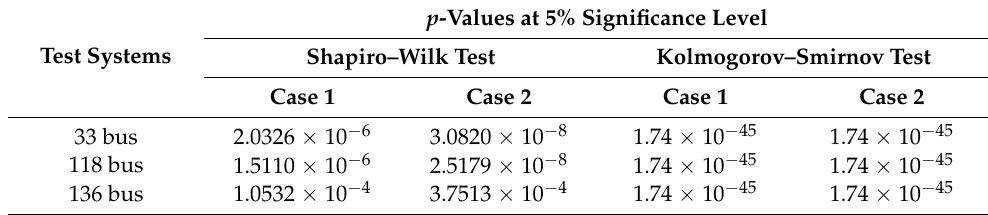
Table 16. Normality test for O-SCMDEA for scenario I applied to the different test systems.